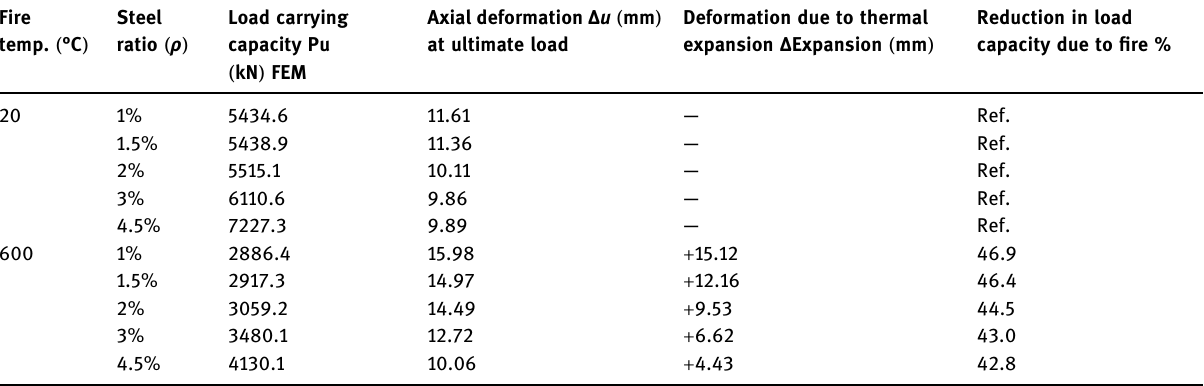
Table 3: The numerical results of analysis of RC column with di ff erent reinforcement ratios